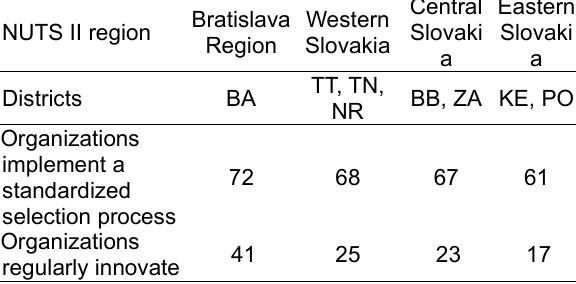
Table 5. Chain index of the companies focusing on